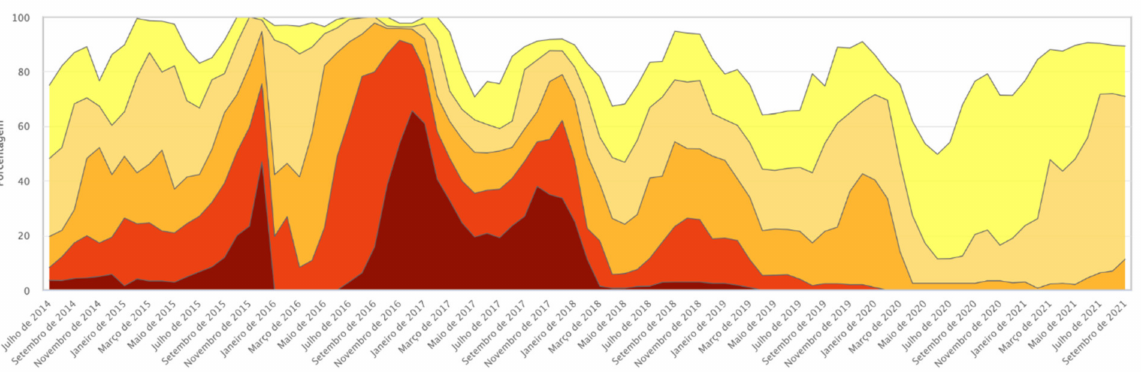
Figure 5. Drought tabular data history. Source: Drought Monitor. Available online: https://